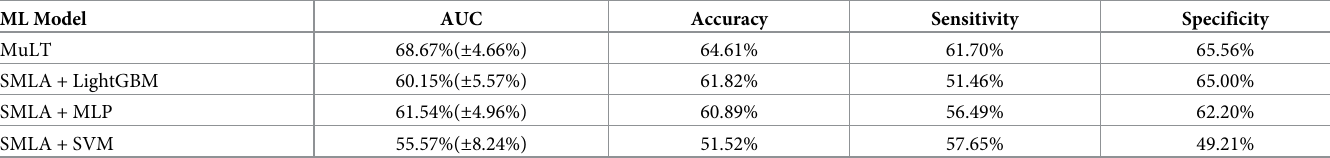
Table 1. Performance of TS predictors created by MuLT and SMLA on 10-fold CV experiments. Namely, sensitivity is the rate of correct prediction of patients identi- fied as sensitive to first line treatments, and specificity describes the correct prediction percentage of patients identified as non-sensitive to first line treatment.